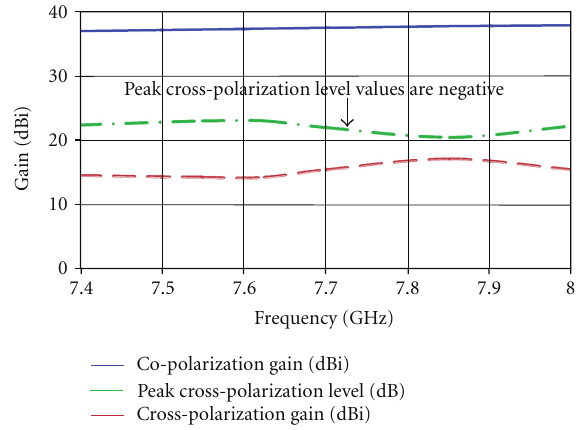
Figure 17: Representation of co- and cross-polarization Gain values along with peak cross-polarization level for the mode combination of TE 11 (40%) + TM 01 (30%) + TE 21 (30%).